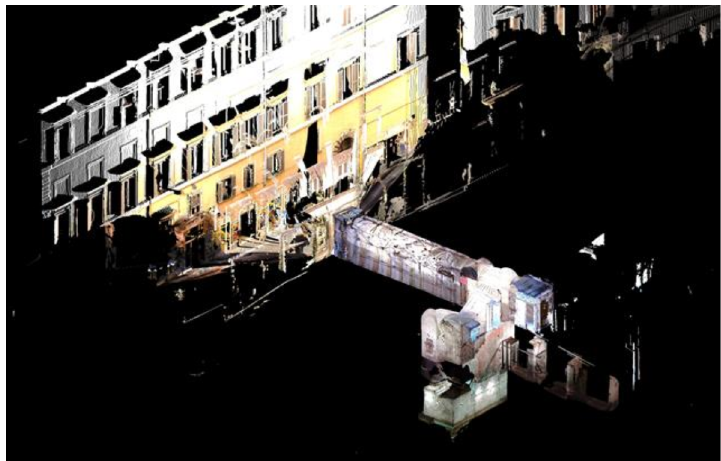
Figure 4. Assembled point cloud, perspective view.